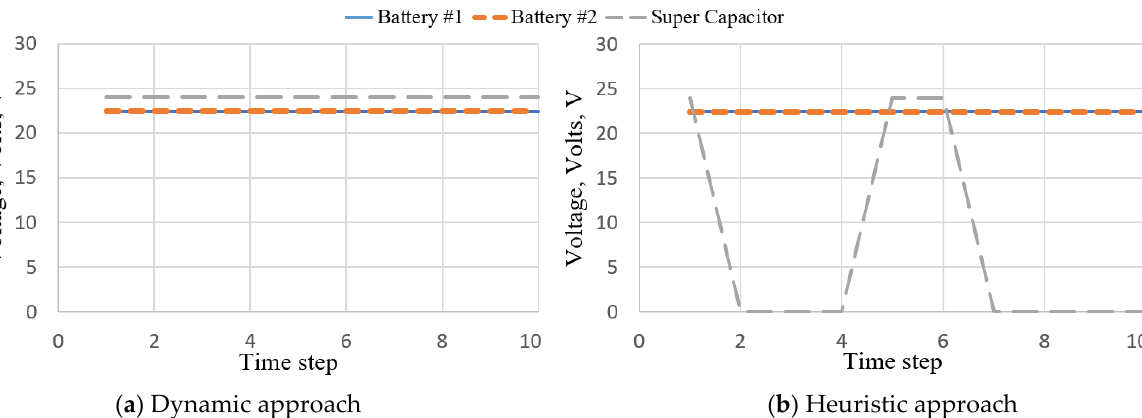
Figure 2. System voltage.